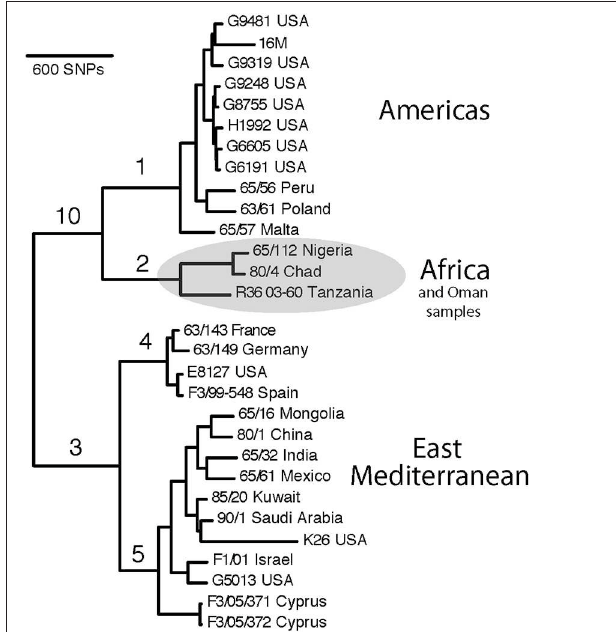
FIGURE 1 | SNP-based phylogenetic tree of Brucella melitensis using 29 genomes available at time of assay development. Numbered branches correspond to SNP-based assays for each of the corresponding lineages. Note that the B. melitensis lineage known as the W. Mediterranean group (includes the Ether strain), is a basal group and is not shown in this tree. Country names indicate where the isolate was identified, and due to travel and sharing of strains among labs, this is not necessarily the country of